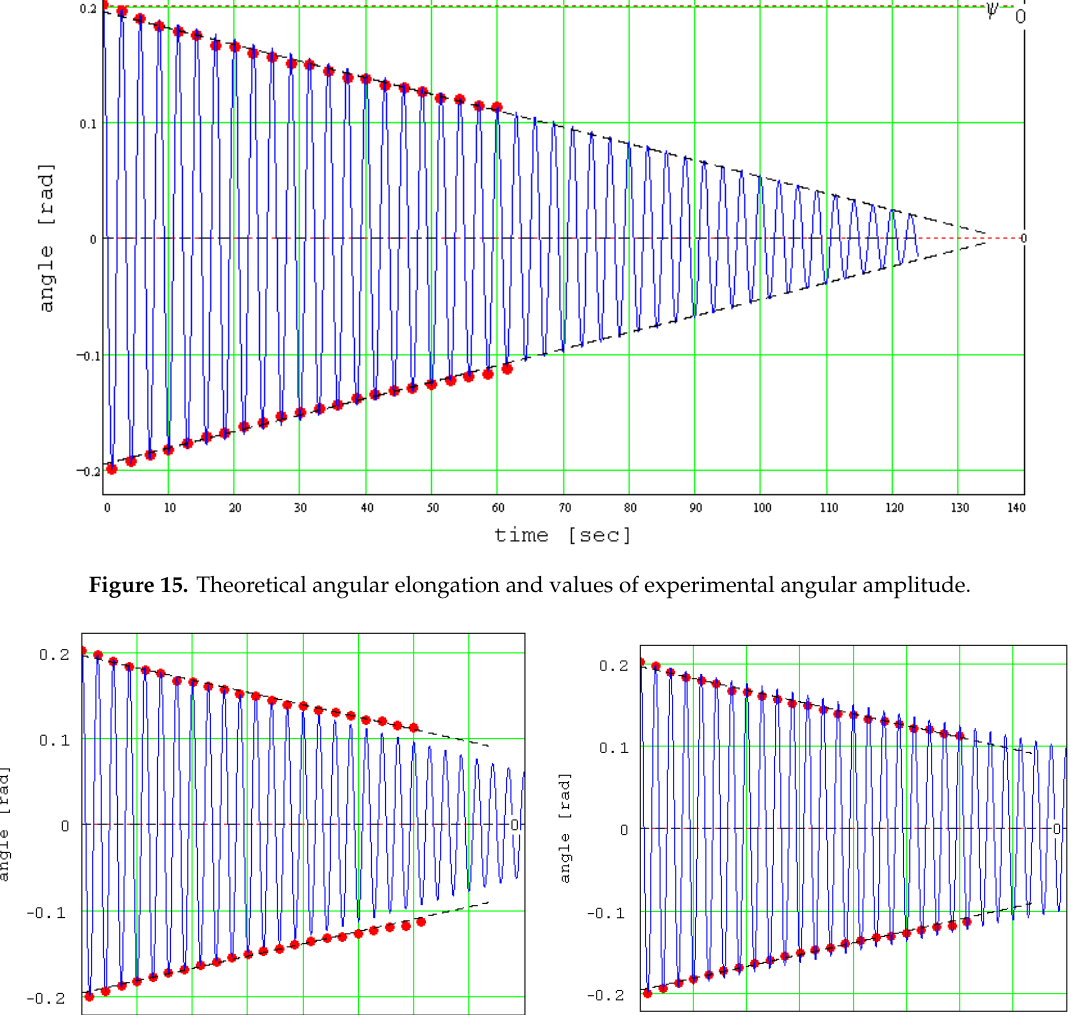
Figure 15. Theoretical angular elongation and values of experimental angular amplitude.